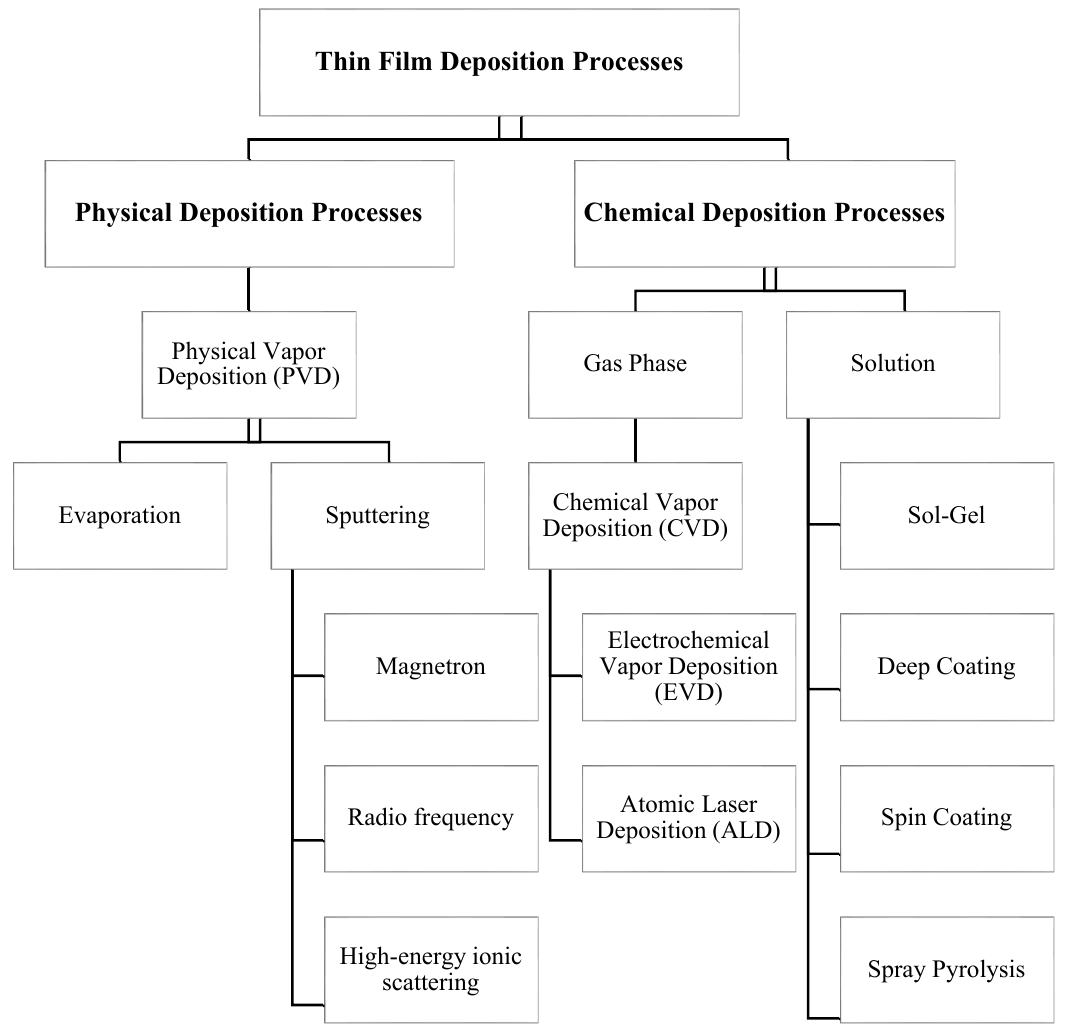
Figure 1. Classification of thin film coating techniques [34].